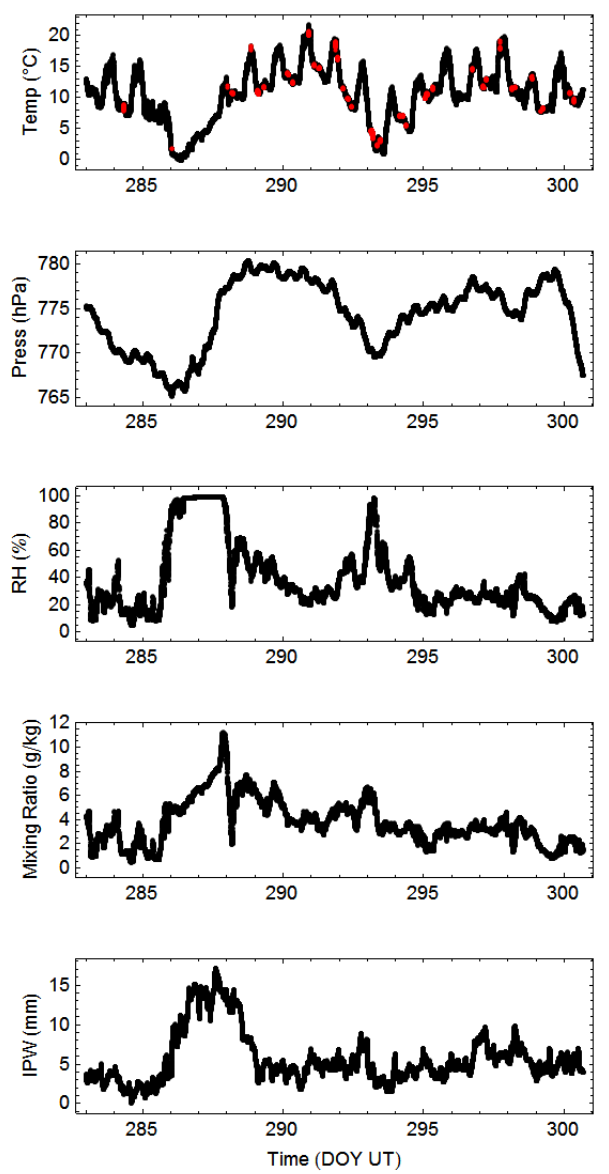
Fig. 1. Time series during MOHAVE-2009 of surface T , P , RH, mixing ratio and total column water from the THPRef and SuomiNet instruments that are part of the ALVICE instrumentation. The times when radiosondes were inserted into the ventilated chamber for comparative measurements are marked with red dots.